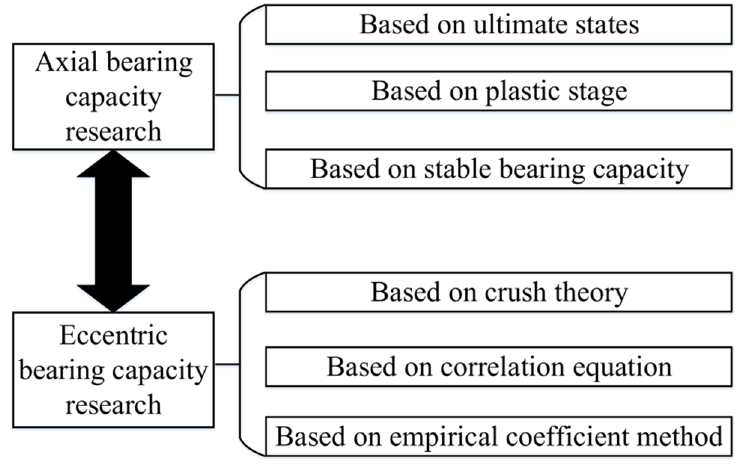
Figure 1. Classical concrete-filled steel tube research system and paradigm.